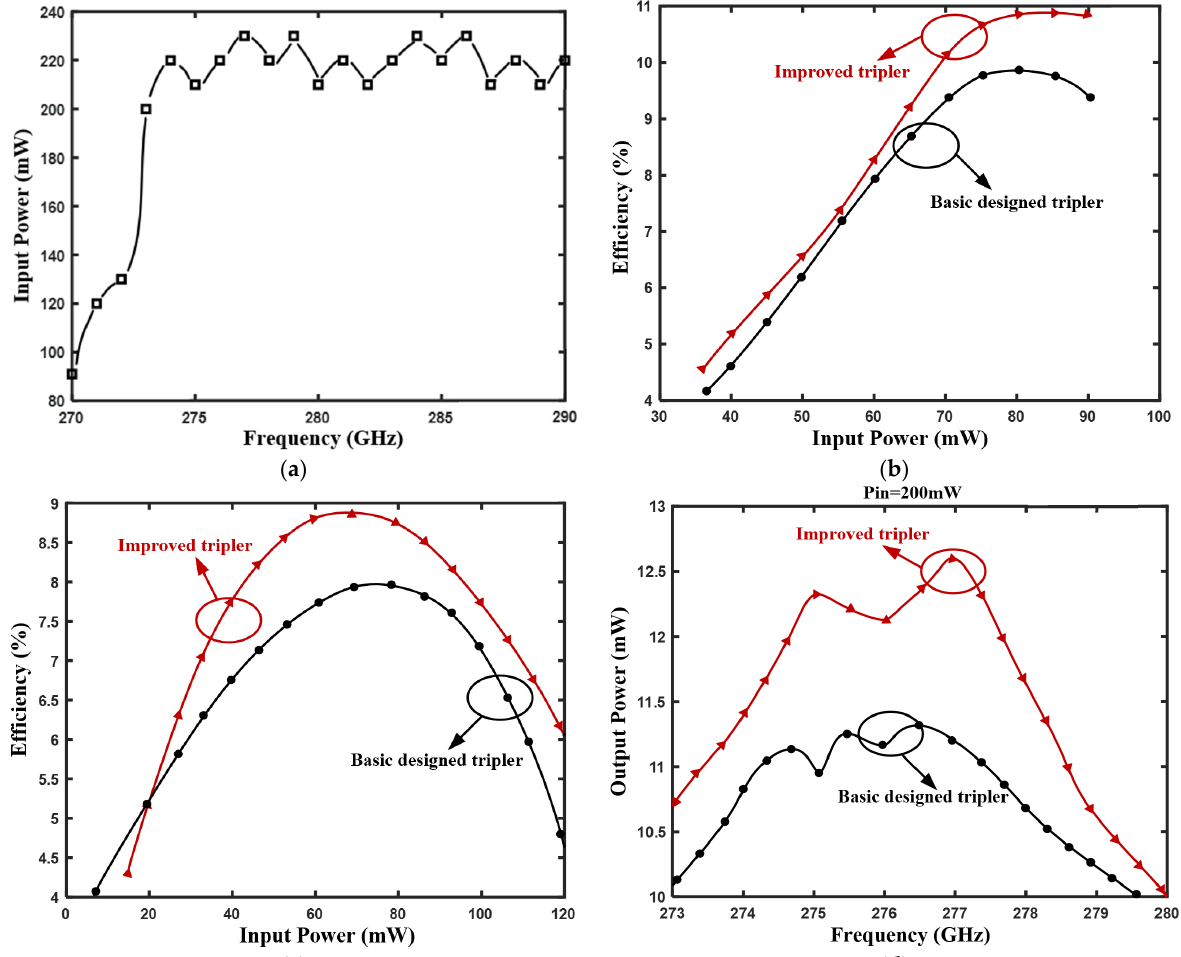
Figure 6. Test results ( a ) Fundamental drive source output power; ( b ) Efficiency vs. input power (at fixed frequency point 270 GHz); ( c ) Efficiency vs. input power (at fixed frequency point 271 GHz); and ( d ) Output power vs. frequency (fixed input power of 200 mW).